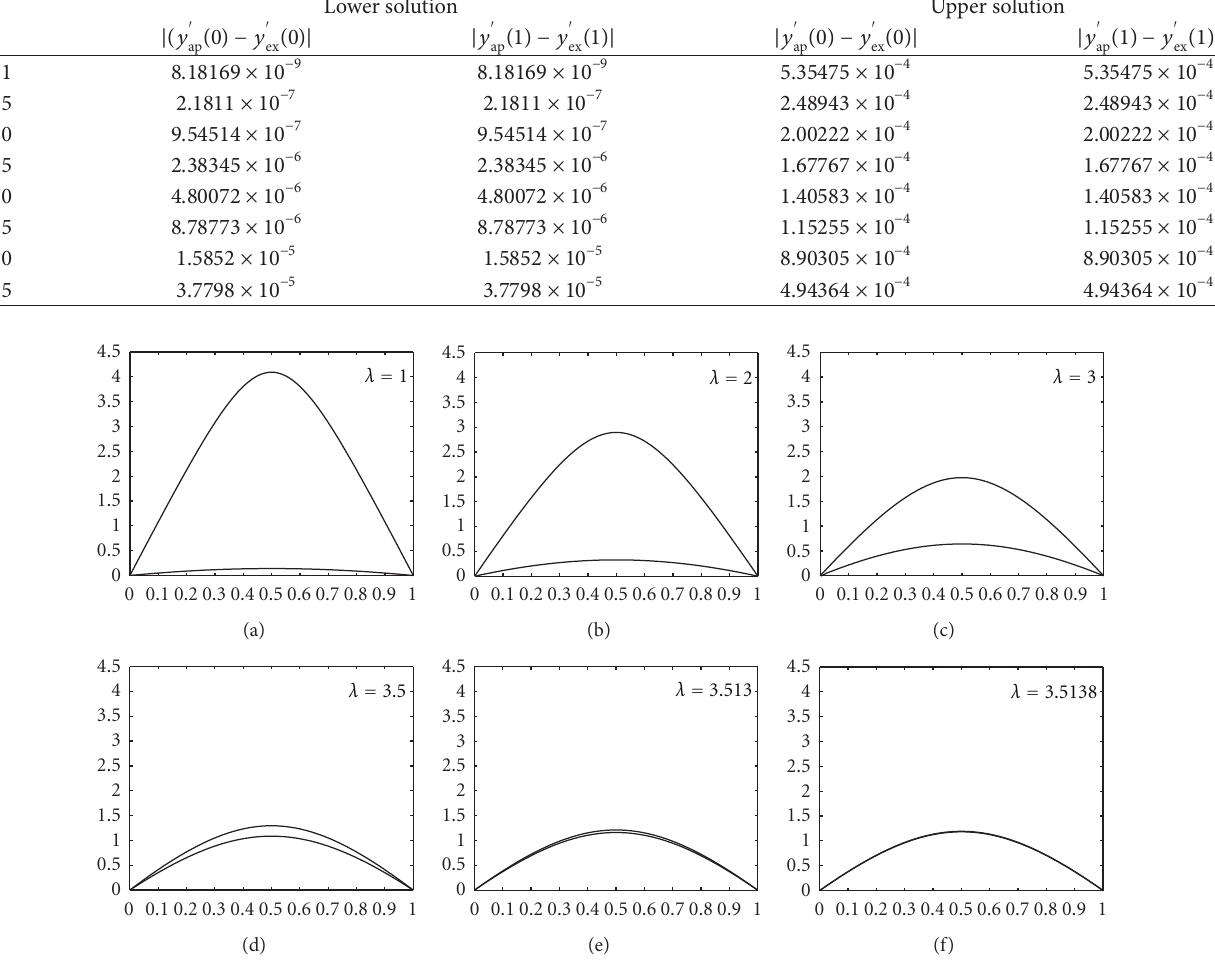
F 3: Numerical solutions of Bratu’s problem (56)-(57)